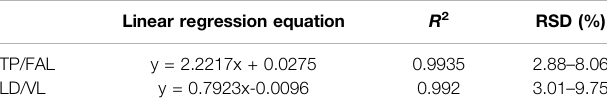
FIGURE 5 | Standard curve of the ratio of peptides in (A) LD/VL and (B) TP/FAL. TABLE 3 | Linear regression equation of the ratio of peptides in the two groups ( n =